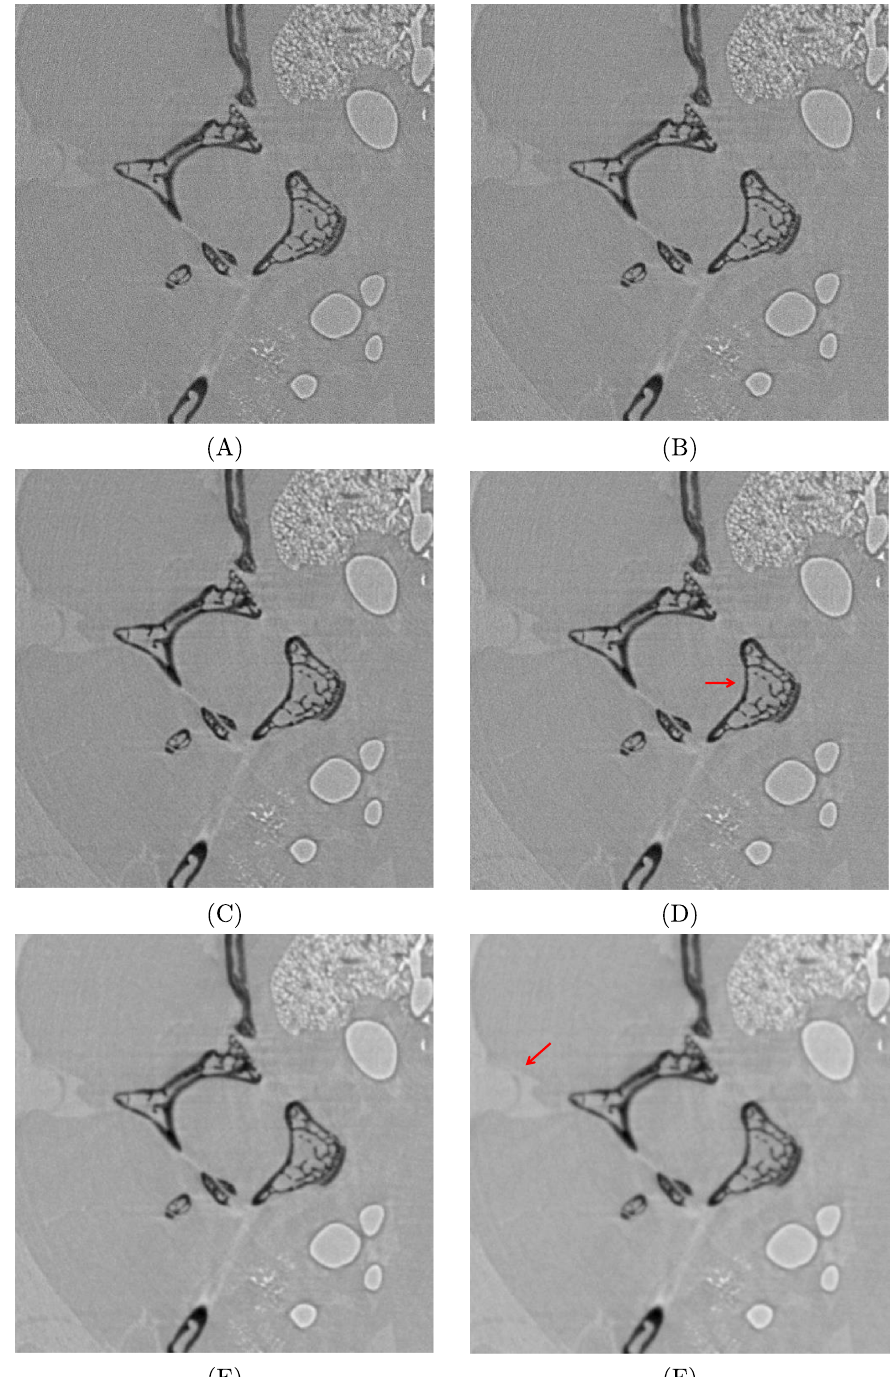
Fig 11. Comparison of reconstructions between FBP and BPWD-W with 1800 projections. FBP with (A) ramp, (B) Shepp-Logan, or (C) Hann filter; BPWD-W with (D) σ = 1, (E) σ = 7, or (F) σ = 15.